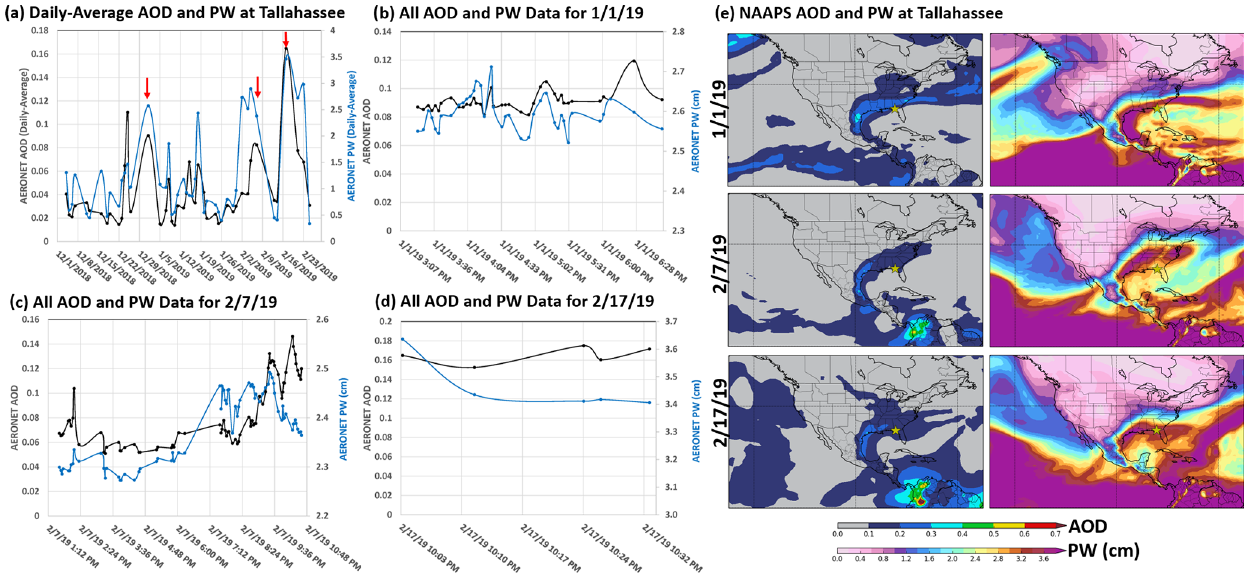
Figure 15. AOD and PW time series at the Tallahassee site, Florida, in which strong positive correlations are observed during the DJF season. The daily-average AOD and PW time series are shown for the 2018–2019 DJF season, with red arrows indicating select events for which joint peaks in AOD and PW are observed (a) . Time series of AERONET data (non-averaged, all data) for dates identified with red arrows are shown in time series (b–d) . Additionally, NAAPS-RA AOD and PW (cm) fields are shown for the same dates, with the AERONET site marked with a yellow star (e)